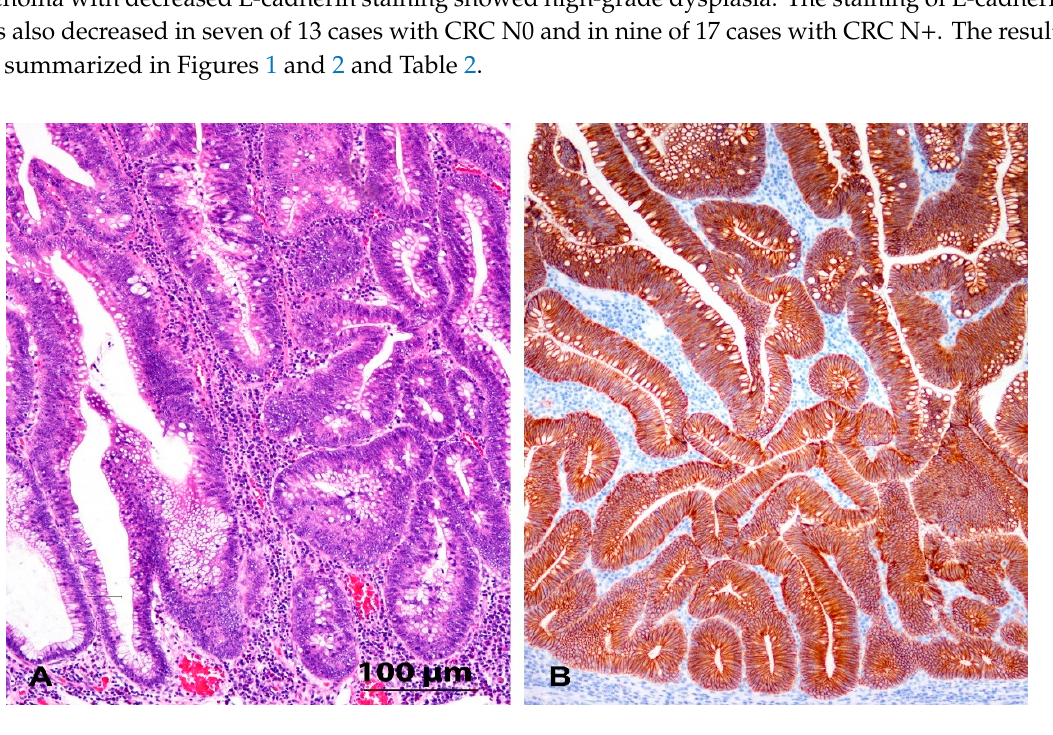
Figure 1. ( A ) Tubular adenoma. HE, orig. magnification 100×; ( B ) Immunohistochemistry for